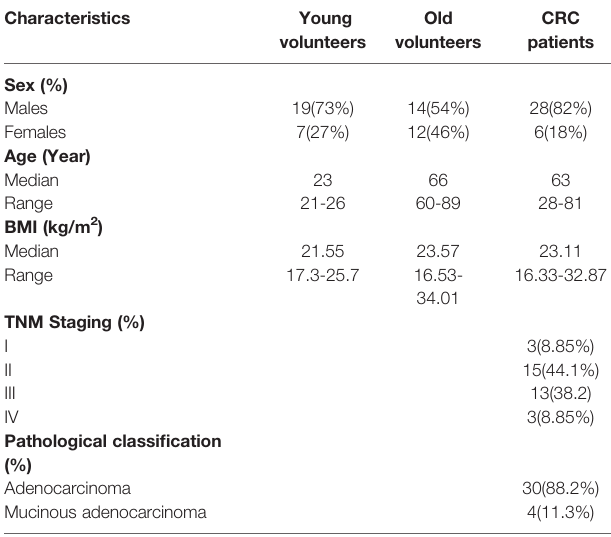
TABLE 1 | Demographic characteristics of the three